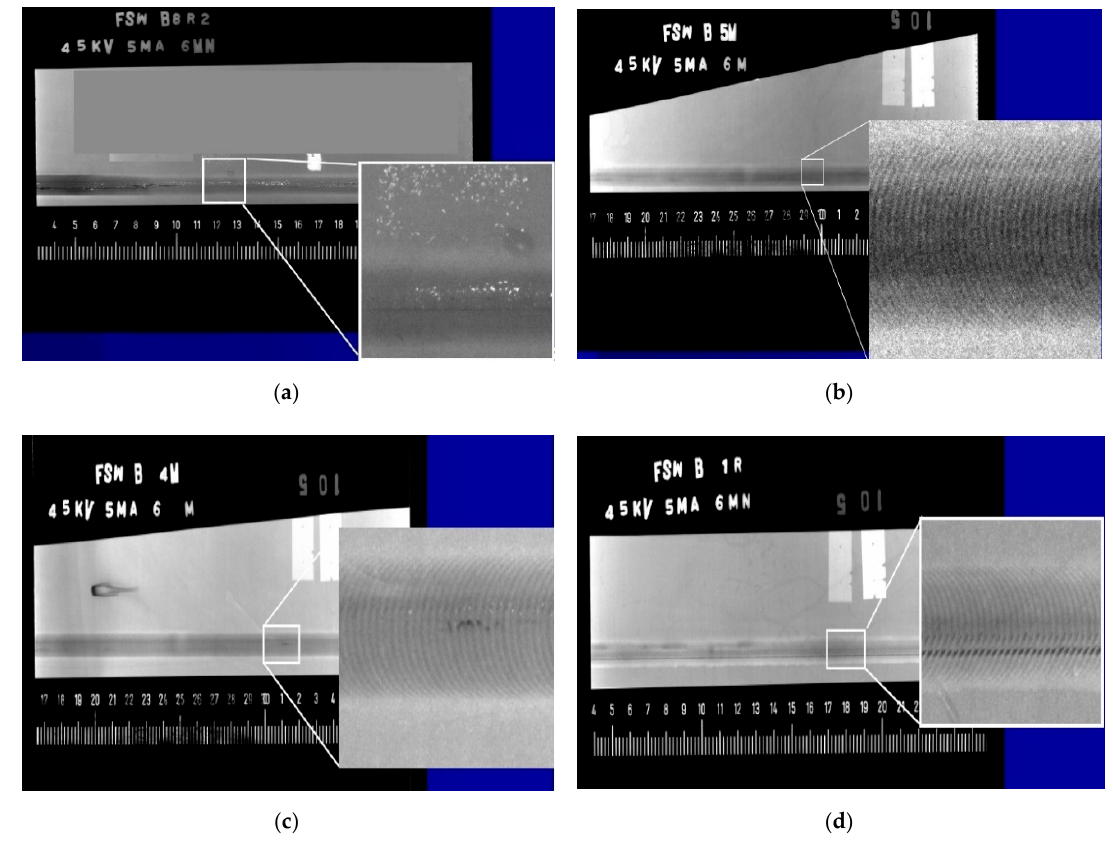
Figure 6. Inspection of friction stir welded panels using X-ray radiography method for detection of wormhole defects: ( a ) no defect, ( b ) very small defect (tiny black spots in left side of zoomed in section), ( c ) small defect, and ( d ) large defect [65].